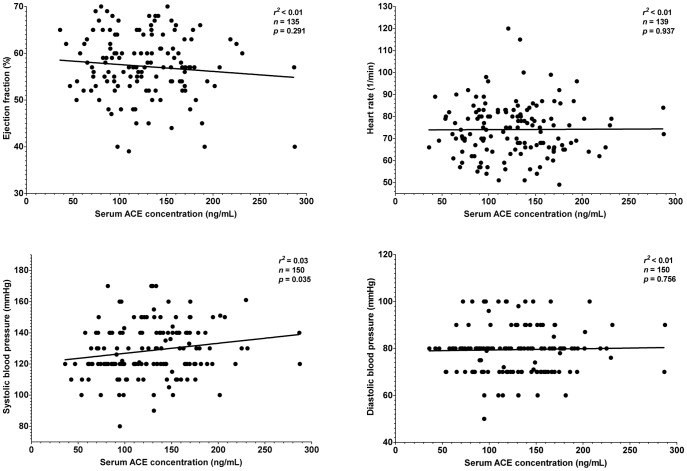
There is no relationship between cardiovascular parameters and serum ACE concentration.Cardiovascular parameters (ejection fraction, heart rate, systolic and diastolic blood pressure) were plotted as a function of the serum ACE concentration (n = 151 patients). Points were fitted by a linear regression to reveal the potential correlation between the plotted parameters. Parameters of the fitting are shown in each graph. Ejection fraction is normally above 50%, heart rate is in the range of 60–100/min, systolic and diastolic blood pressure is in the range of 90–140 and 60–90 mmHg.